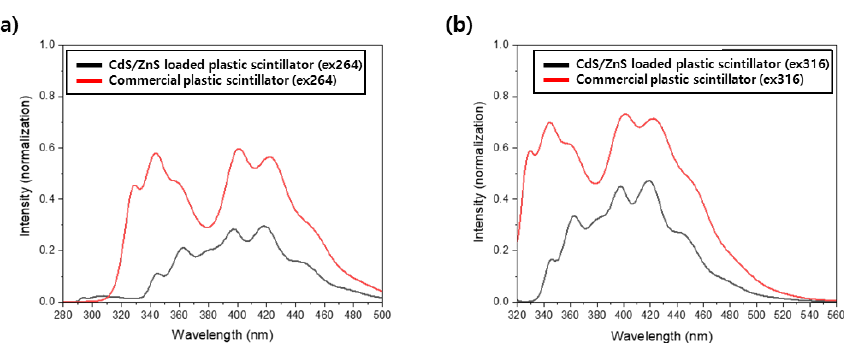
Figure 4. Photoluminescence analysis of plastic scintillators by excitation wavelength (plastic thick- ness used is 30 mm): ( a ) excitation at 264 nm; ( b ) excitation at 316 nm.